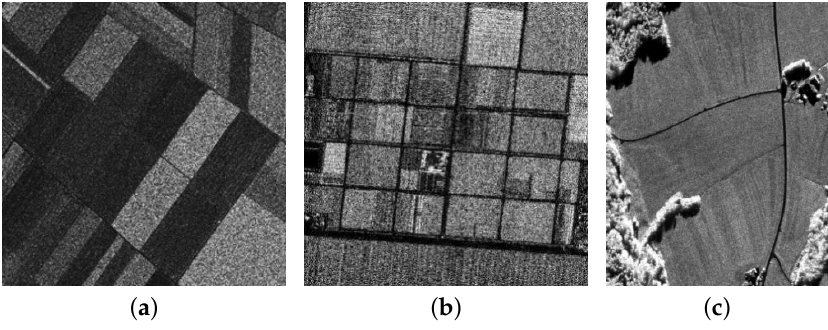
Figure 9. Real SAR images: ( a ) Noerdlinger image, ( b ) Maricopa image, ( c ) Traunstein